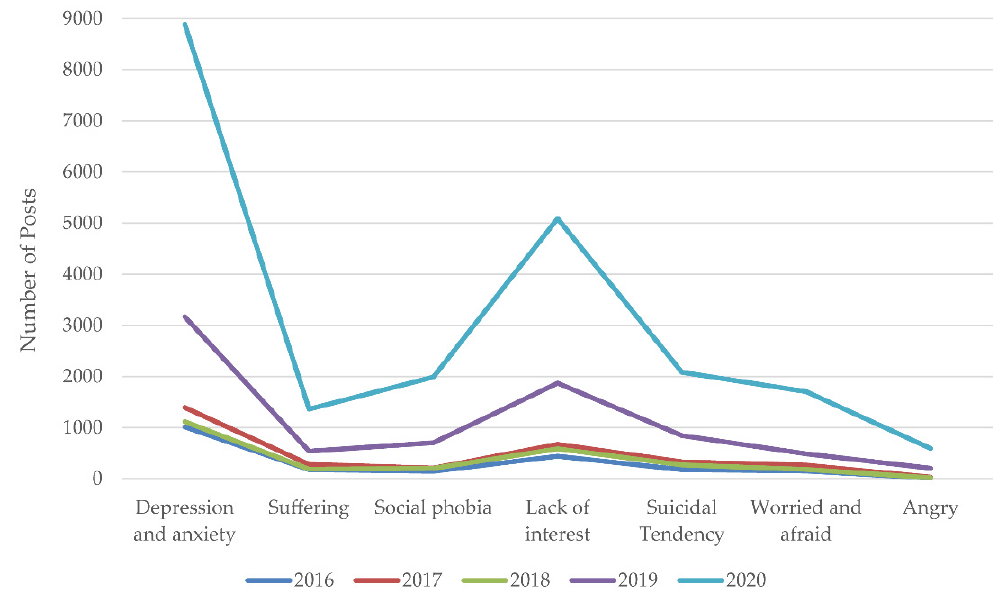
Figure 3. The yearly trends of posts related to different psychological problems before and during the COVID-19 pandemic.